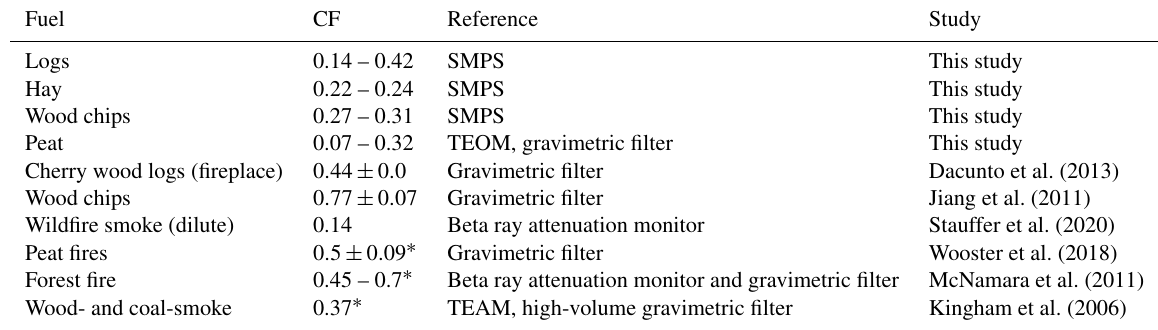
Table 4. AM520 CF results compared to previous studies. Fuel